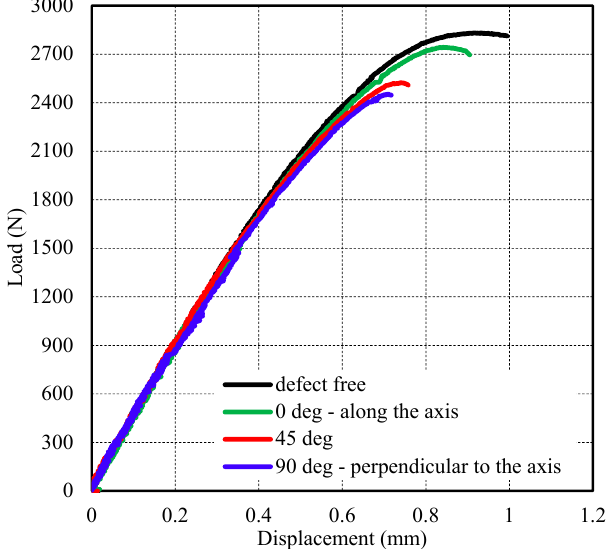
Figure 3. Load-displacement curves for the green sample set with an elliptical defect located at the sample center with different orientations.